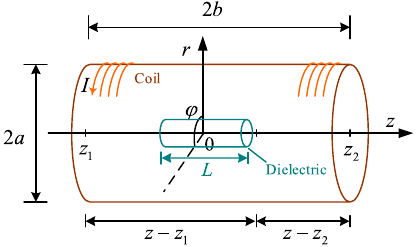
Figure 2. Schematic diagram of the solenoid